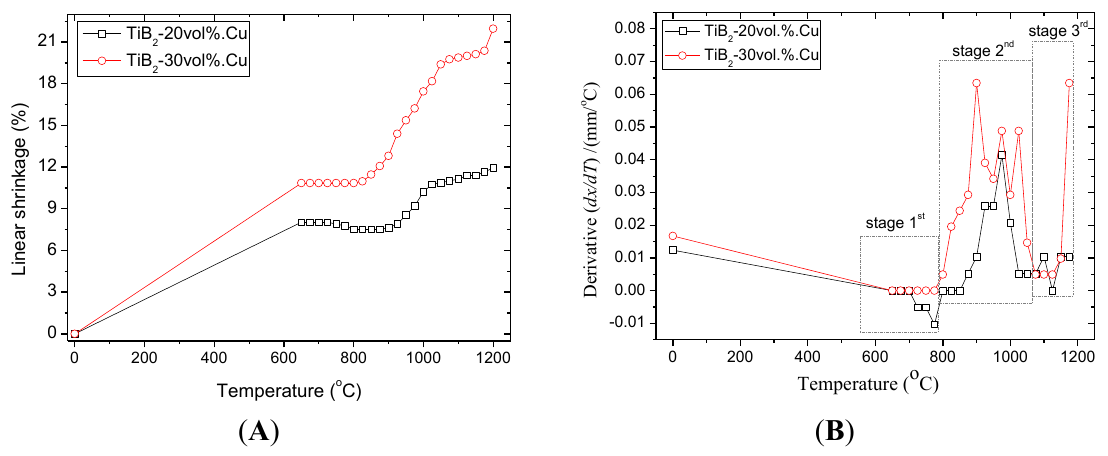
Figure 1. Graphs representing the displacement in Spark Plasma Sintering (SPS) sintering for samples sintered using rapid heating mode: ( A ) Linear shrinkage with temperature; ( B ) derivative graph representing changes in linear shrinkage with changing temperature (d x /d T ) = f ( T